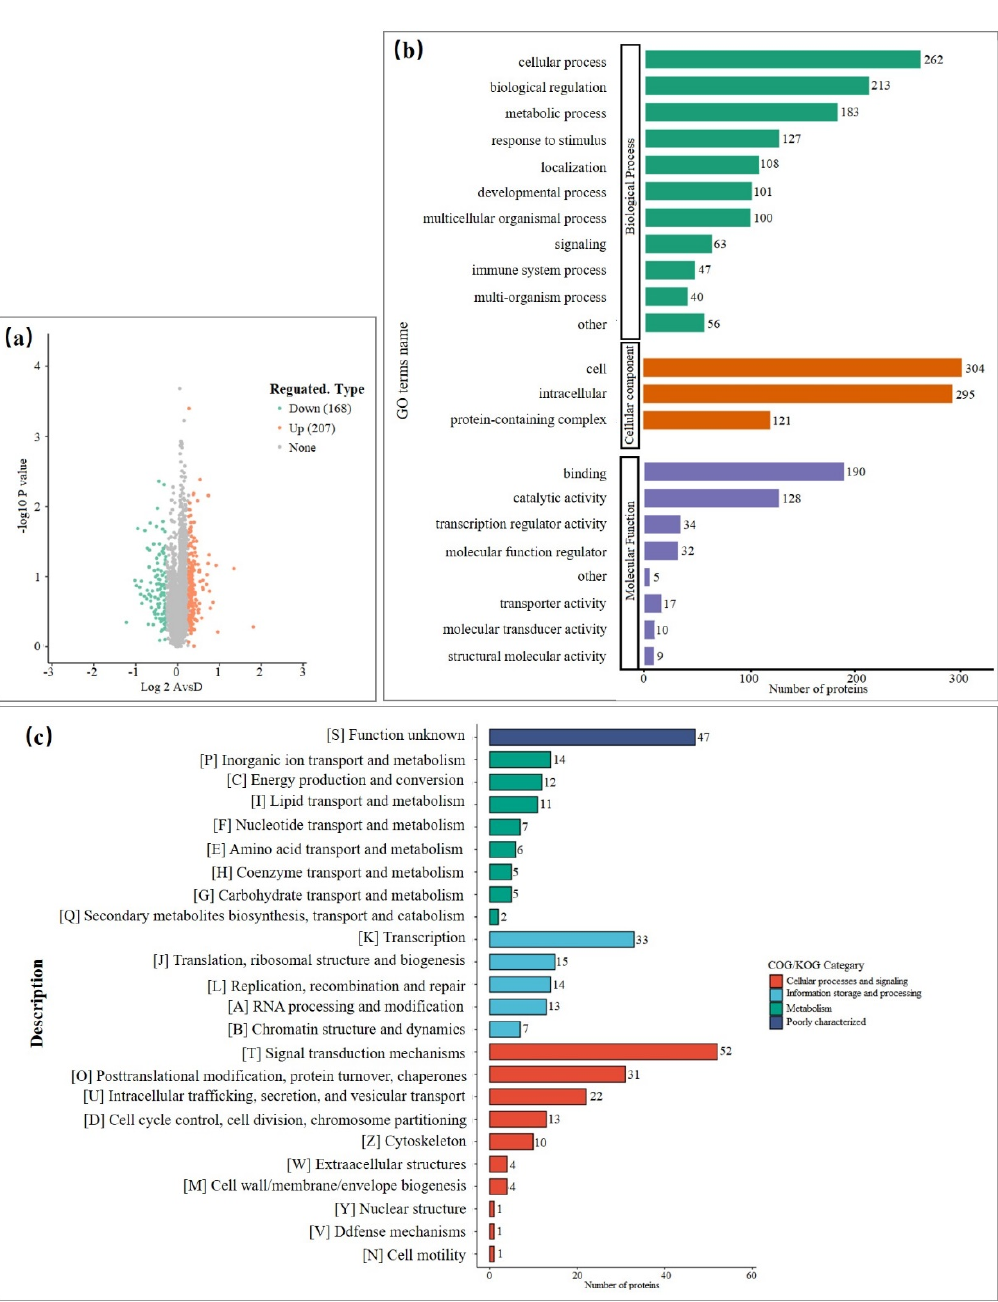
plemented in MEGA X. ( b ) Viral recombination was further analyzed and the potential recombinant breakpoints were identified by RDP4.0. BOOTSCAN on the basis of pairwise distance with 100 boot- strap replicates. ( c ) The time tree was calculated in MEGA X where divergence time was inferred by the RelTime with Dated Tips (RTDT) method. The PAstV-1 strain (AB032272) (grey color) was des- ignated as an outgroup taxon and all sequences used the year of sampling dates as the tip dates for calibration constraints. The divergence time of each branch is marked. PAstV-1, PAstV-2, PAstV-3, PAstV-4, and PAstV-5 strains are circled in different colors of dotted boxes.